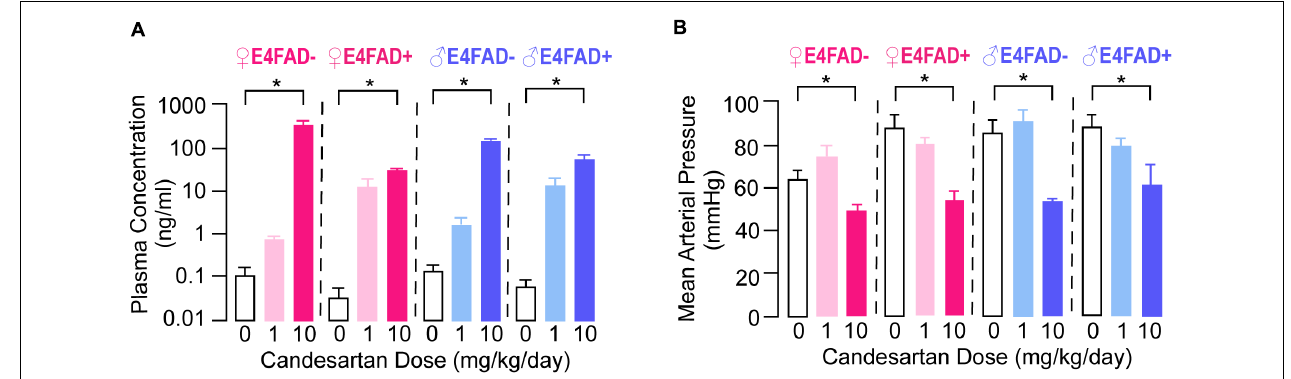
FIGURE 1 | Female and male E4FAD − and E4FAD + mice treated with high-dose candesartan had higher plasma levels of candesartan and lower blood pressure compared to vehicle. (A) Female and male E4FAD − and E4FAD + mice treated with 10 mg/kg/day candesartan (high dose) had higher plasma drug levels than mice treated with vehicle (0 mg/kg/day) [Female E4FAD − : F (2, 6) = 13.38, p = 0.006. Female E4FAD + : F (2, 5) = 19.10, p = 0.0046. Male E4FAD − : F (2, 4) = 324.6, p < 0.0001. Male E4FAD + : F (2, 6) = 13.53, p = 0.006]. (B) Female and male E4FAD − and E4FAD + mice treated with 10 mg/kg/day candesartan had lower mean arterial blood pressure at treatment endpoint compared to vehicle (Female E4FAD − : F (2, 19) = 6.54, p = 0.0069. Female E4FAD + : F (2, 22) = 11.95, p = 0.0003. Male E4FAD − : F (2, 20) = 14.04, p = 0.0002. Male E4FAD + : F (2, 24) = 4.56, p = 0.021). All data expressed as mean + / − SEM. * p < 0.05 by one-way ANOVA and Dunnet’s post-hoc analysis for candesartan dose compared to vehicle. See Supplementary Table 2 for details on n size and statistical